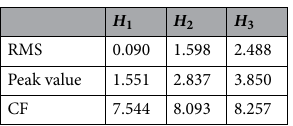
Table 7. Indicator evaluation level and reference value.